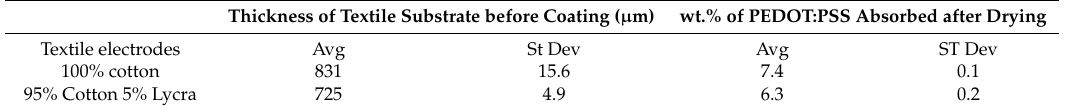
Table 1. Thickness of textile substrate before coating and wt.% of PEDOT:PSS absorbed after drying.